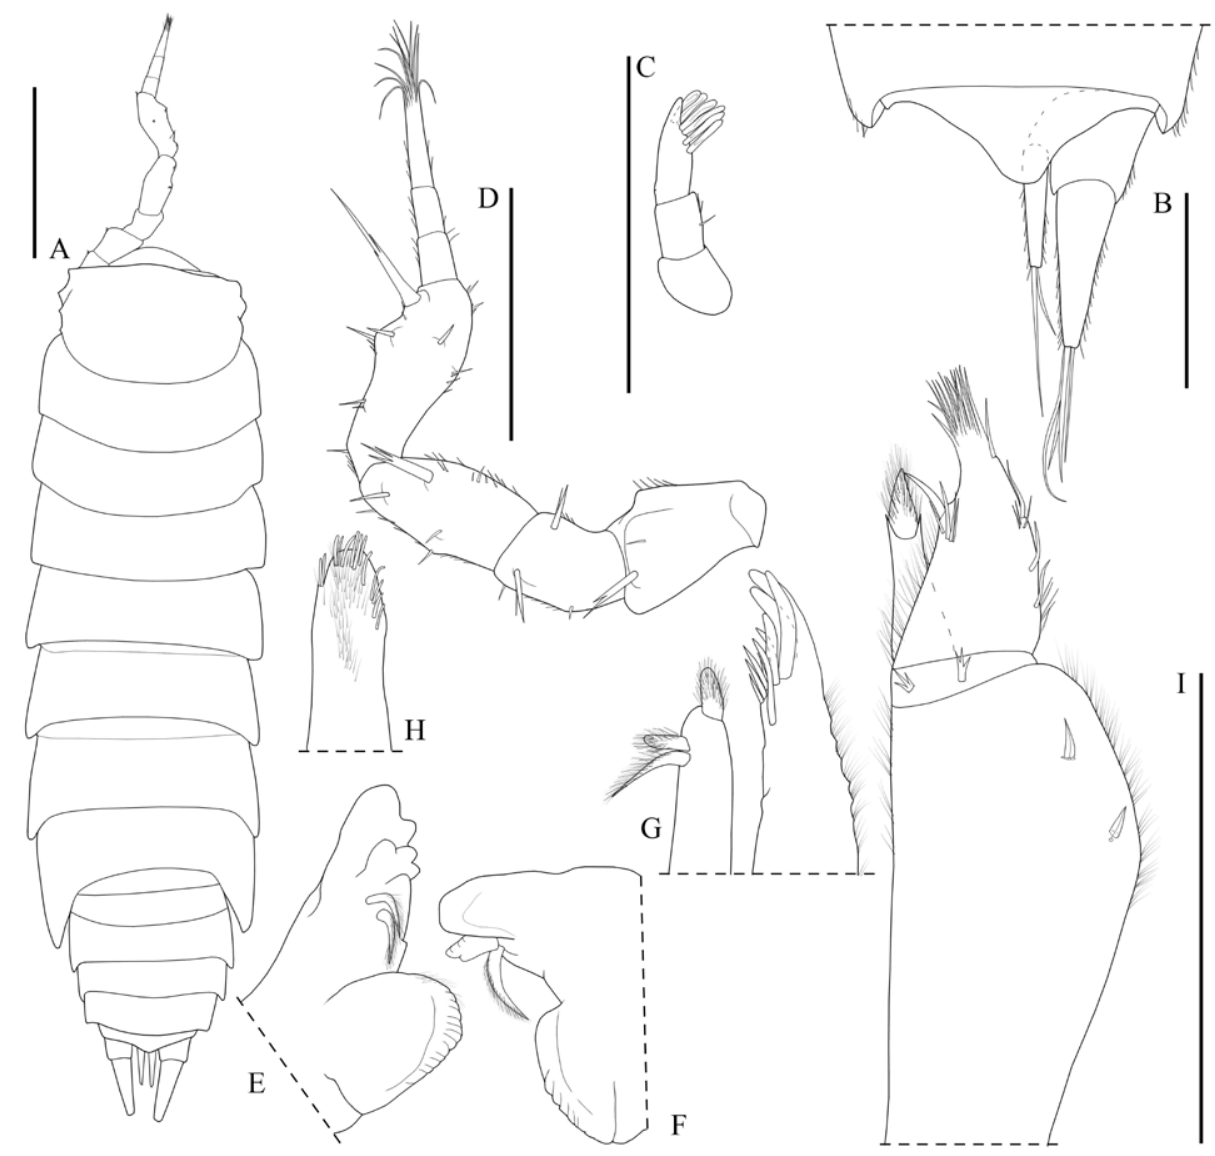
Figure 17. Pectenoniscus morrensis n. sp. Male paratype: A , habitus, dorsal view; B , cephalon, frontal view; C , pleonite 5, pleotelson and uropod, dorsal view; D , antennula; E , antenna; F , left mandible; G , right mandible; H , maxillula; I , maxilla; J , maxilliped. Scale bars: A : 0,5 mm; B–J : 0.2